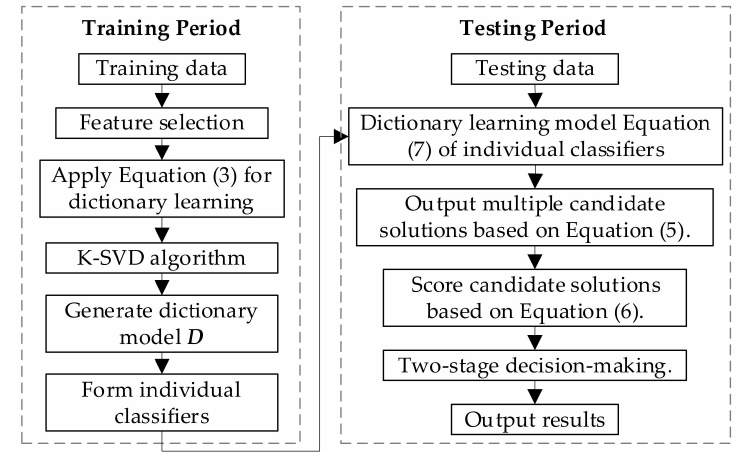
Figure 3. Algorithm flow of the ensemble method-based